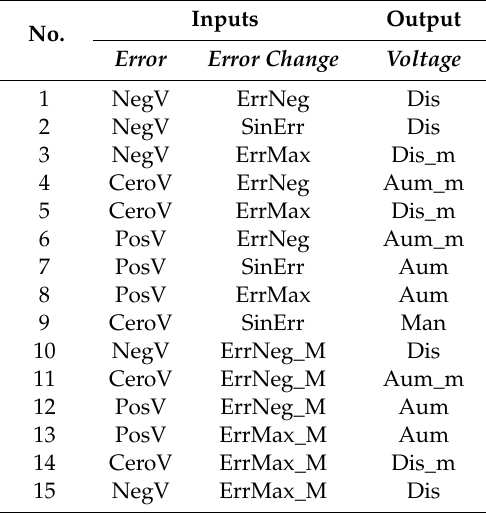
Table 8. Proposed combination of fuzzy rules.